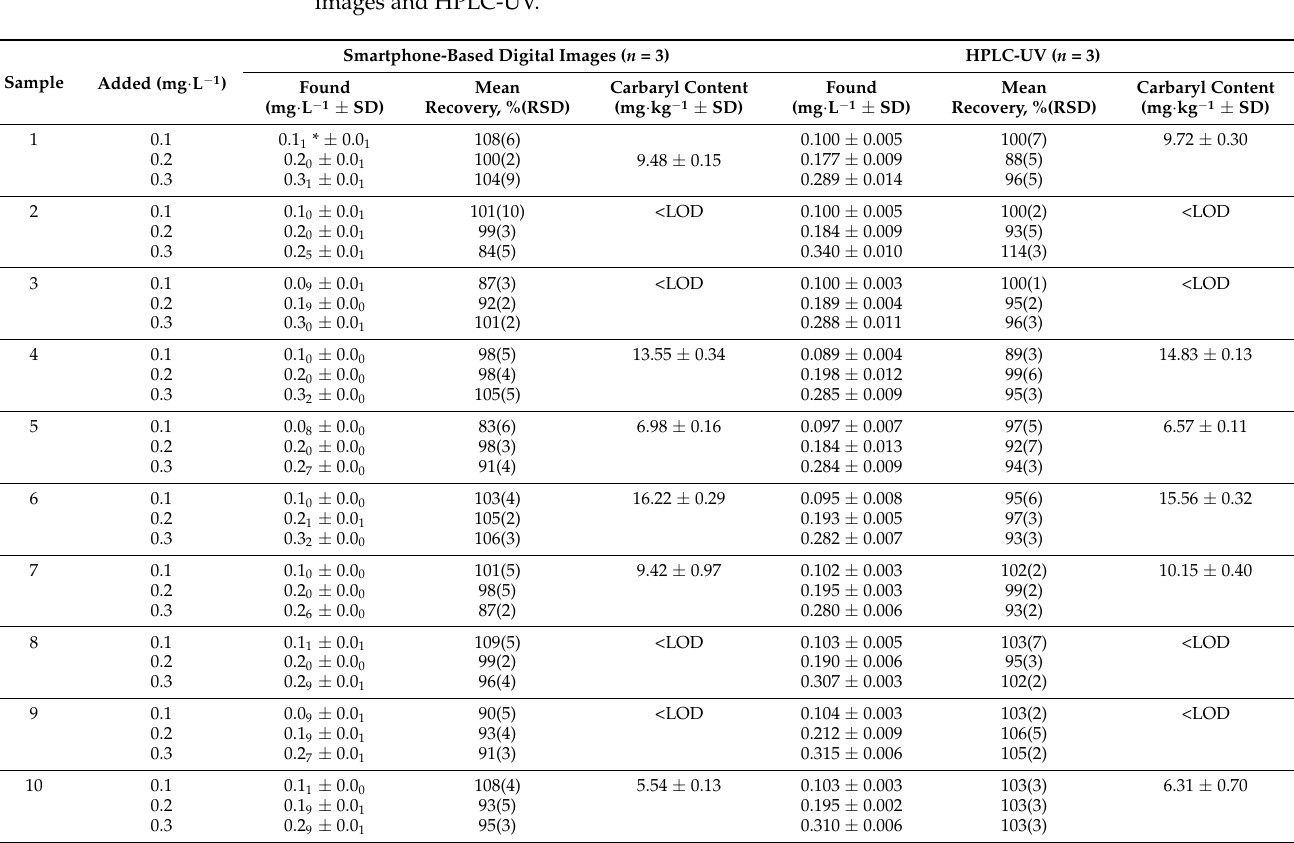
Table 2. Mean recovery percentage of spiked standard carbaryl into real samples and concentration of carbaryl residues in Andrographis paniculate herbal medicines obtained by smartphone-based digital images and